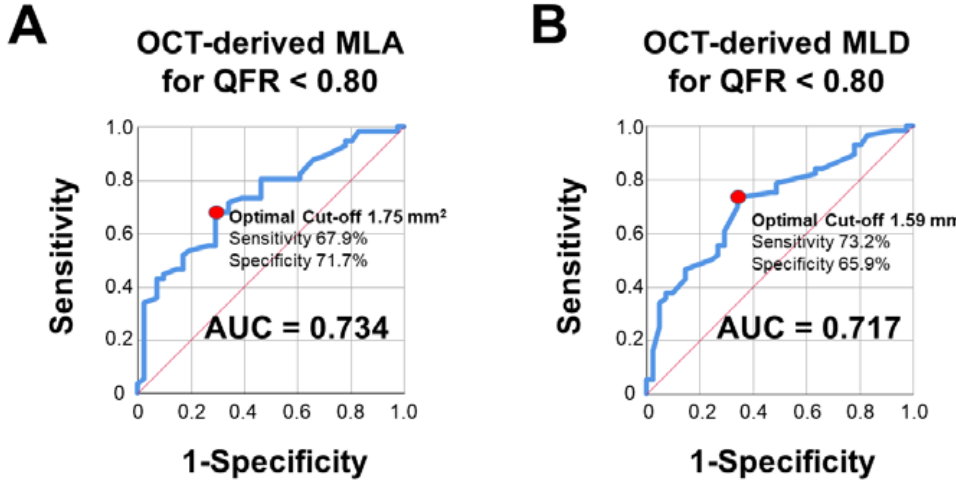
Figure 6. Diagnostic efficiency of OCT-derived stenosis parameters in predicting pathological QFR ( ≤ 0.80). Both MLA ( A ) and MLD ( B ) presented a good diagnostic efficiency in detecting hemodynamically relevant stenoses according to QFR. Abbreviations as in previous figures.